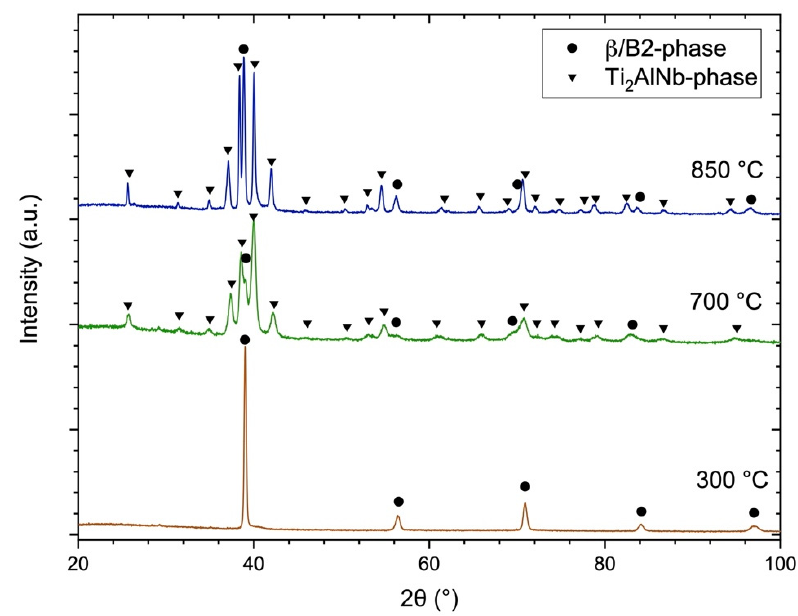
Figure 7. XRD patterns of the samples produced from the Ti 2 AlNb-CYB powder at 300, 700, and 850 °C substrate preheating temperatures in the as-fabricated condition.